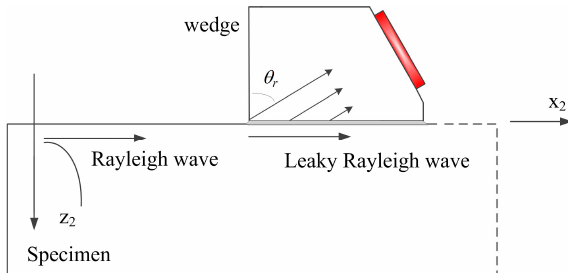
Figure 4. Sketch of Rayleigh wave reception by an angle beam wedge transducer, where (leaky) Rayleigh wave propagates on the specimen surface, and the decreasing length of the arrows in the wedge describes the amplitude diminishing of the leaky field under the wedge.